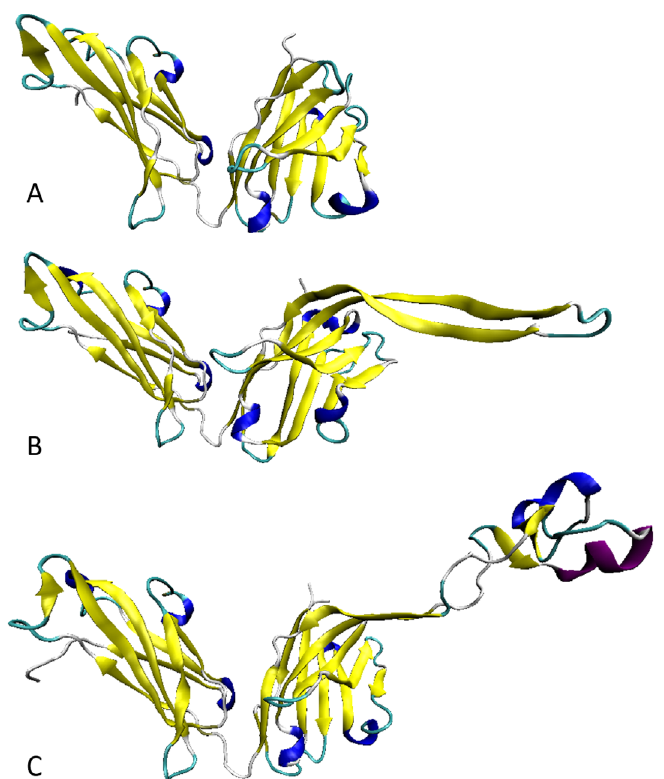
Figure 6. Structural characterization of anti-HIV Abs of human or bovine origin. (A) Non-neutralizing HIV Ab 13H11 (PDB ID: 3MO1); (B) broadly reactive and potent HIV-1 neutralizing human Ab PG9 (PDB ID: 3U1S; [49]); (C) potent HIV-1 bNAb NC-Cow1 (PDB ID: 6OO0;